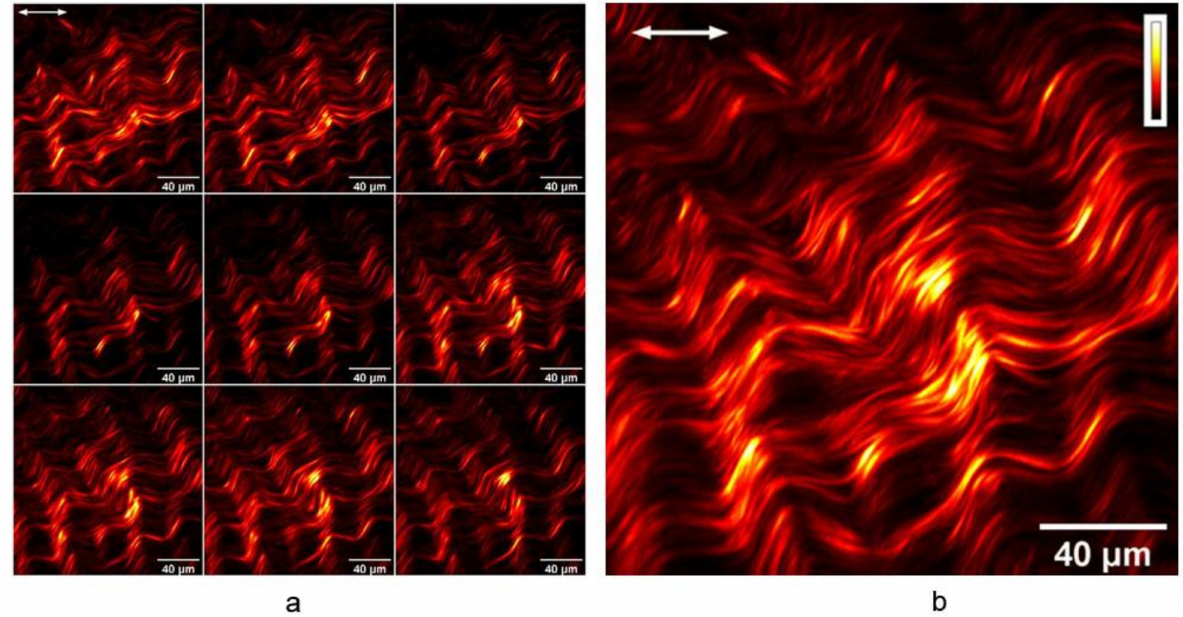
Figure 1. ( a ) A 3D SHG image from a collagen-rich sample. Sequential optical sections of 2 µ m apart were recorded. ( b ) A z-projection to the maximum intensity of all the 9 slices of ( a ). The arrow indicates the incident horizontal laser polarization. The calibration bar denotes the maximum (white) and minimum (black) SHG intensity